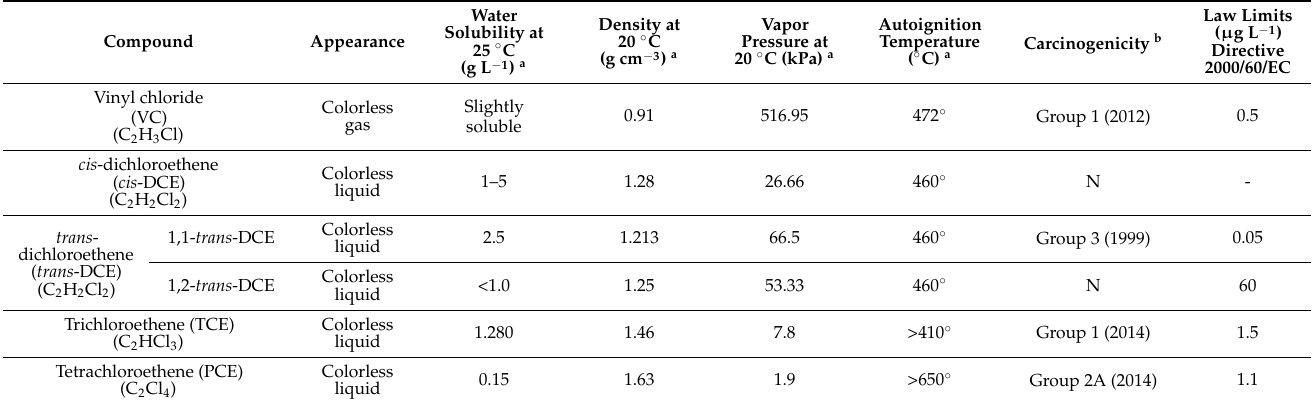
Table 1. Selected characteristics of chlorinated ethenes a .